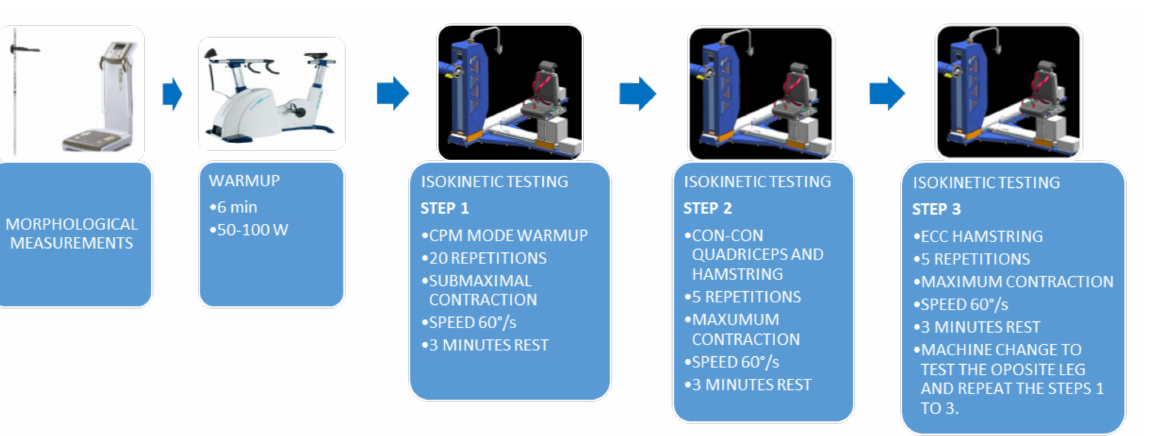
Figure 1. Flowchart of the testing